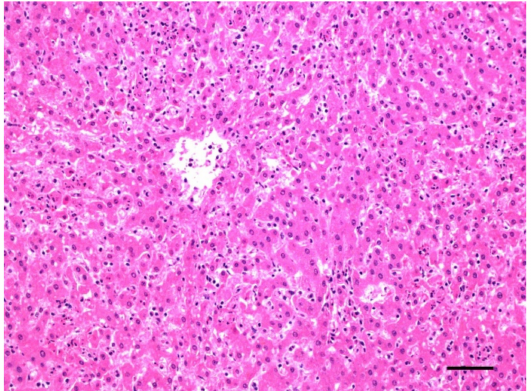
Figure 8. Liver of a lamb with yellow lamb disease, showing marked centrilobular degeneration. Hematoxylin and eosin. Bar = 100 µ